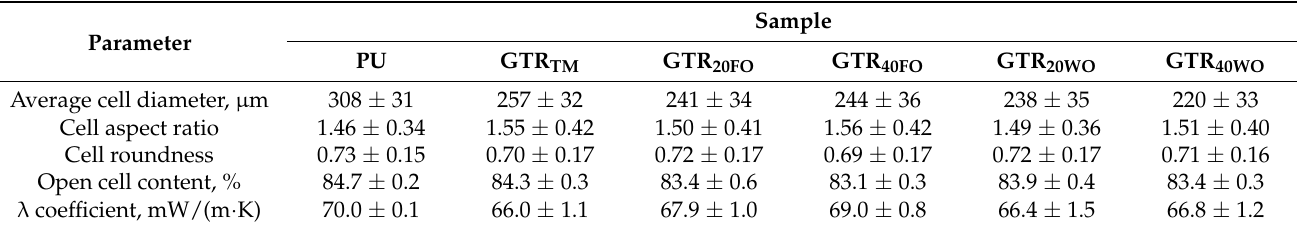
Table 4. The parameters of the cellular structure of prepared foams.